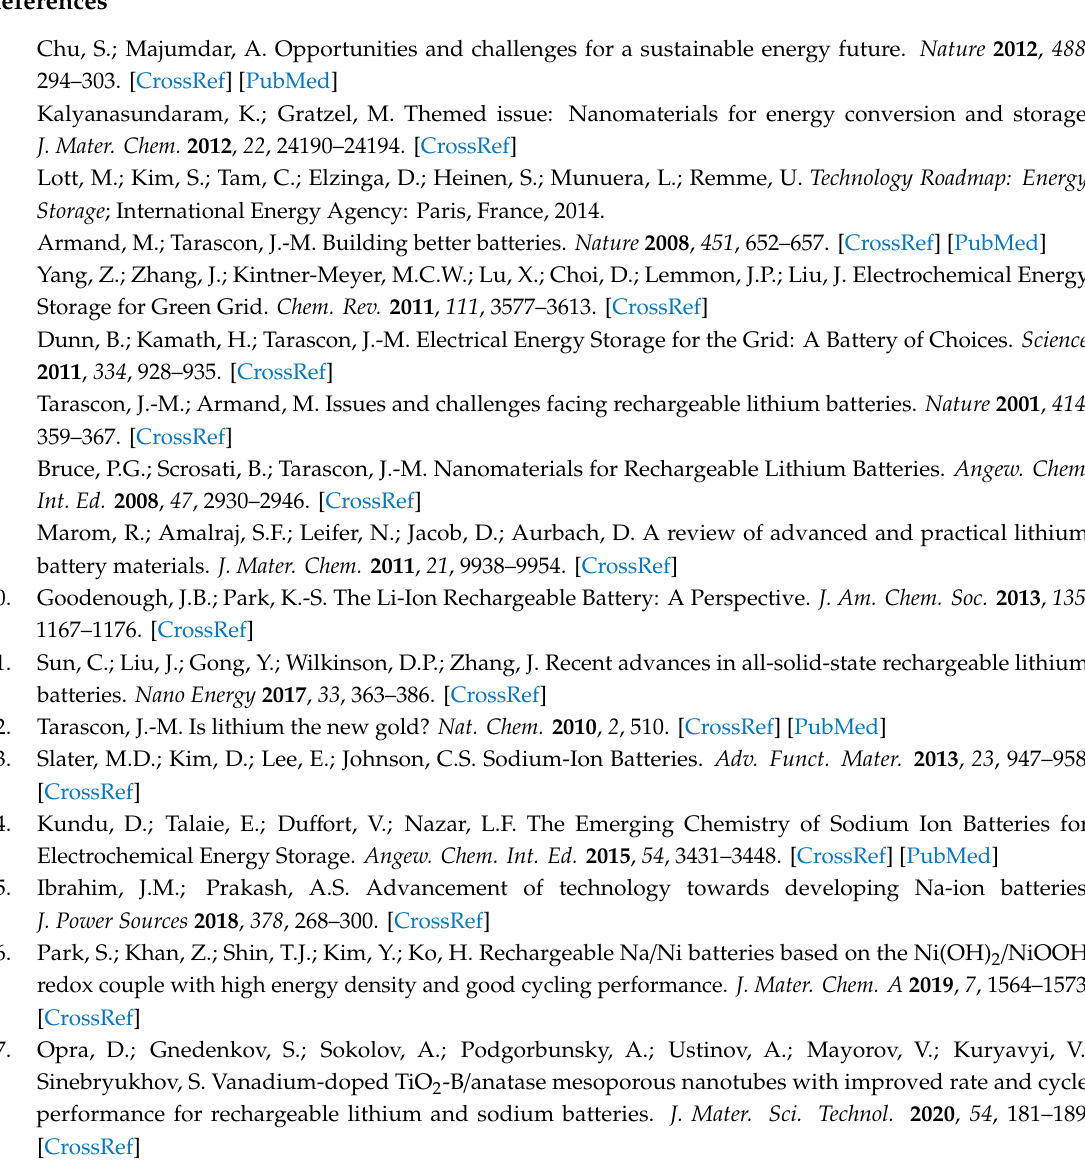
Figure S1: Morphology changes produced by the reduction of (a) GO to (b) rGO upon solvothermal treatment, as displayed by the SEM analysis. Figure S2: Obtainment of GO and its subsequent reduction to rGO, as ascertained by means of (a) MRS, (b) XRPD and (c) XPS. Figure S3: Results of TGA. Table S1: Results of TGA. Table S2: Binding energies and energy splitting of the spin-orbit components of Fe 2p, Ti 2p and Mn 2p core levels. Figure S4: Results of deconvolution of Mn 2p 3 / 2 core level in the composite α -Fe 2 O 3 :Mn@rGO30. Table S3: Results of deconvolution of Mn 2p core level in the composite α -Fe 2 O 3 :Mn@rGO30. Table S4: Surface elemental composition of the samples (from XPS spectra). Figure S5: Potential / capacity profiles of electrodes based on composites (a) α -Fe 2 O 3 @rGO-30, (b) α -Fe 2 O 3 :Ti@rGO-30 and (c) α -Fe 2 O 3 :Mn@rGO-30. Figure S6: Nyquist plots for electrodes based on composites α -Fe α -Fe 2 O 3 @rGO-50 and 2 O 3